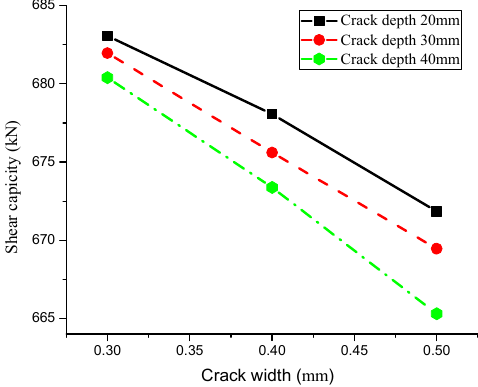
Figure 12. Relationship between crack width and shear capacity.